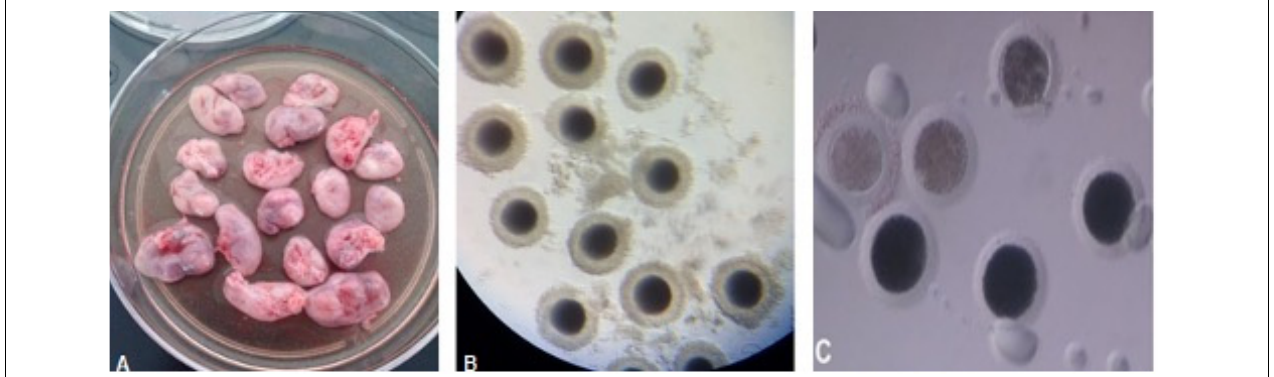
FIGURE 1 | (A) Bitch ovaries that were previously washed and freed from ovarian tissue. (B) Grade I cumulus–oocyte complexes (COCs) recovered from the ovaries by the slicing method. The COCs had dark and uniform cytoplasm, large size, and two or more layers of cumulus cells. (C) Denuded canine oocytes. The presence of pale-looking oocytes is observed after 72 h of in vitro maturation